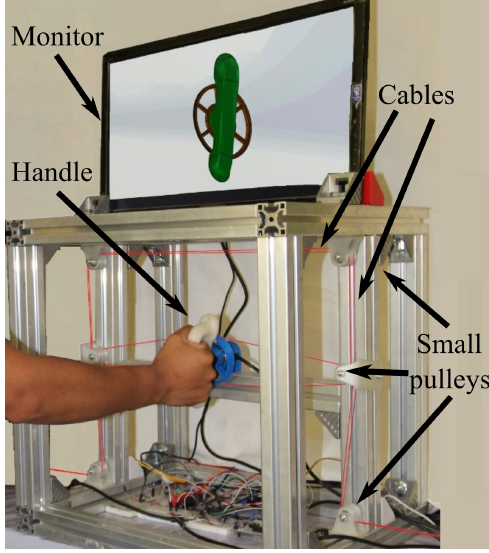
Figure 2. Experimental